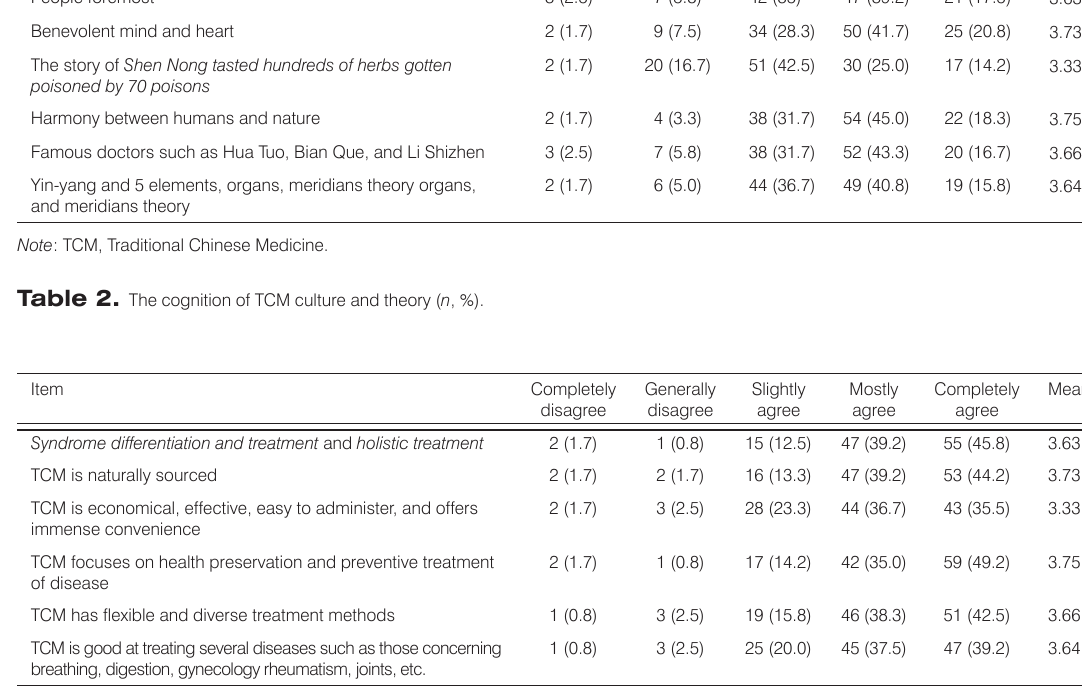
Table 3. Advantages and characteristics of TCM diagnosis and treatment ( n , %).